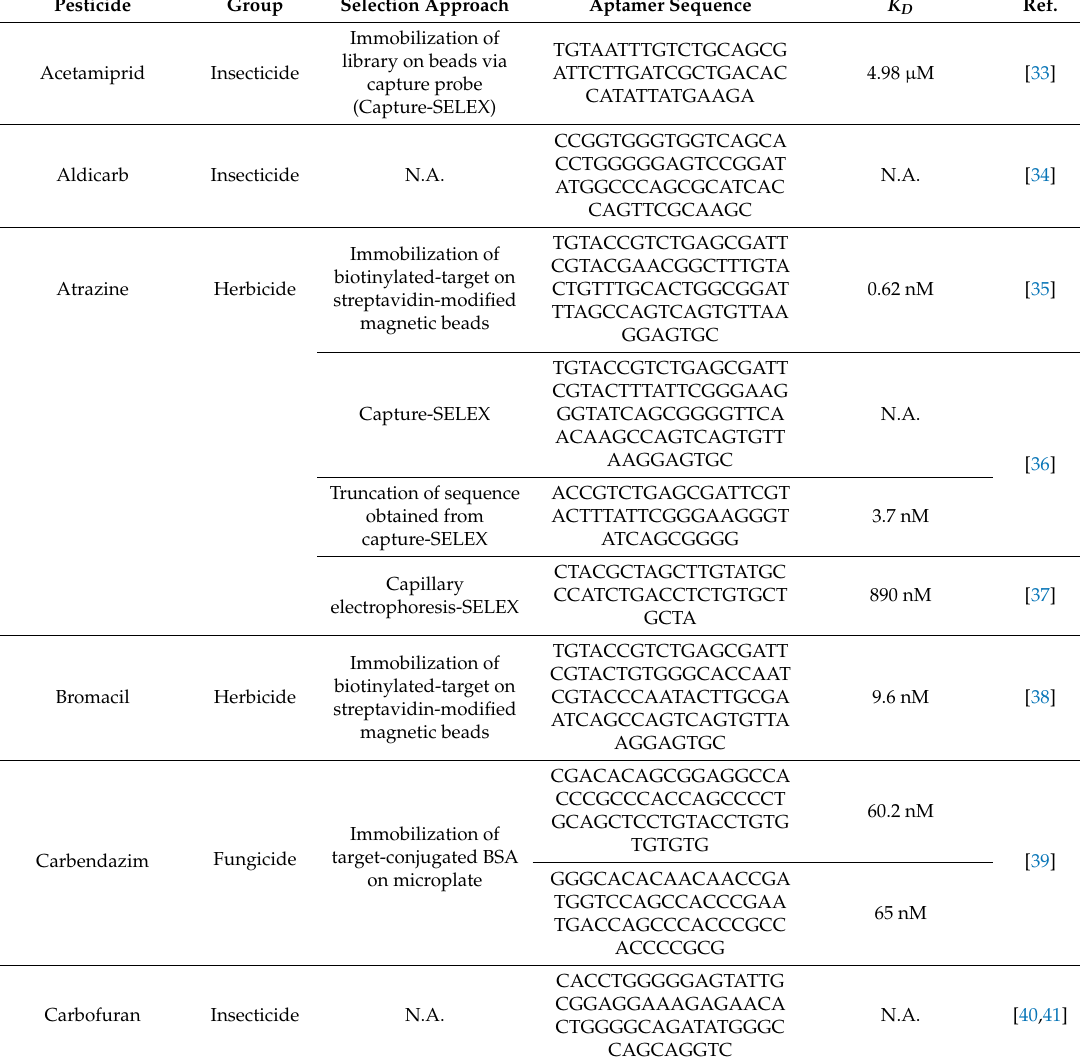
Table 1. Available aptamer sequences for specific targeted